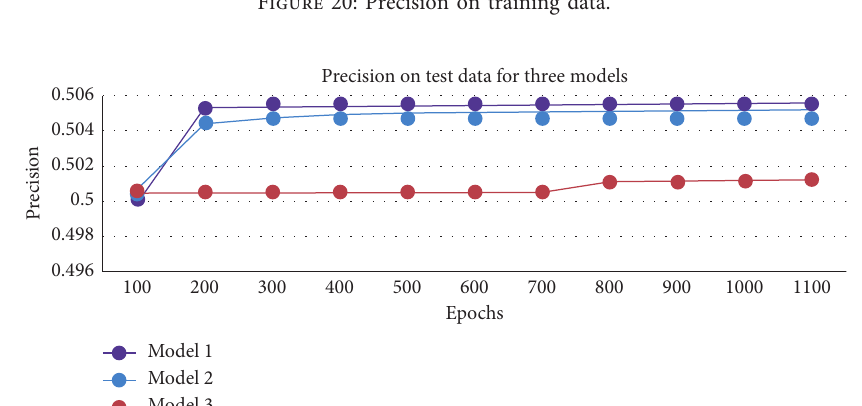
Figure 20: Precision on training data.